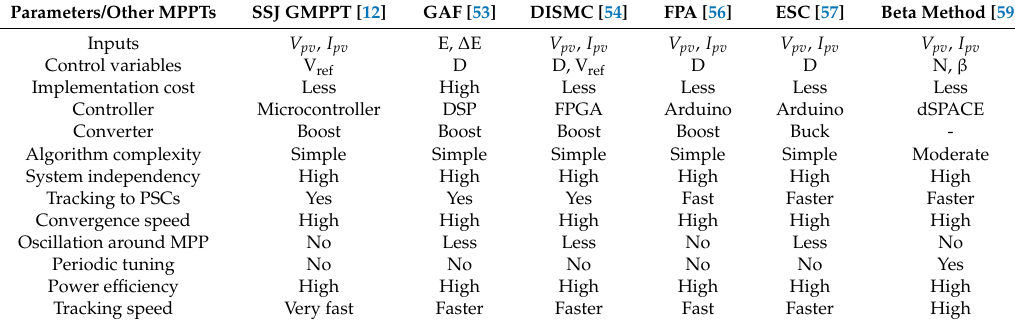
Table 3. Comparison of other